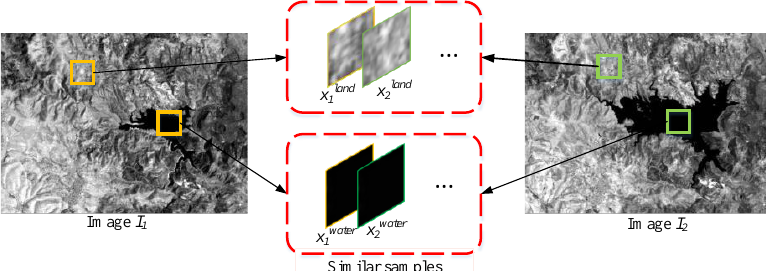
Figure 3. The imaging characteristics between homogenous image pairs I 1 and I 2 . The same reality has the similar statistical properties such as the land and water areas. We can hardly distinguish between the two samples x land 1